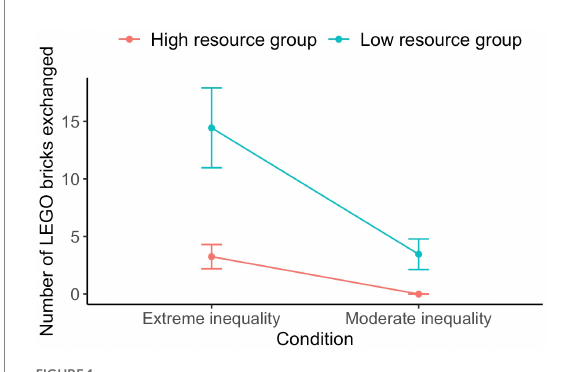
FIGURE 1 Average number of LEGO bricks transferred when sharing was initiated per condition and resource group for Study 2. Error bars represent standard